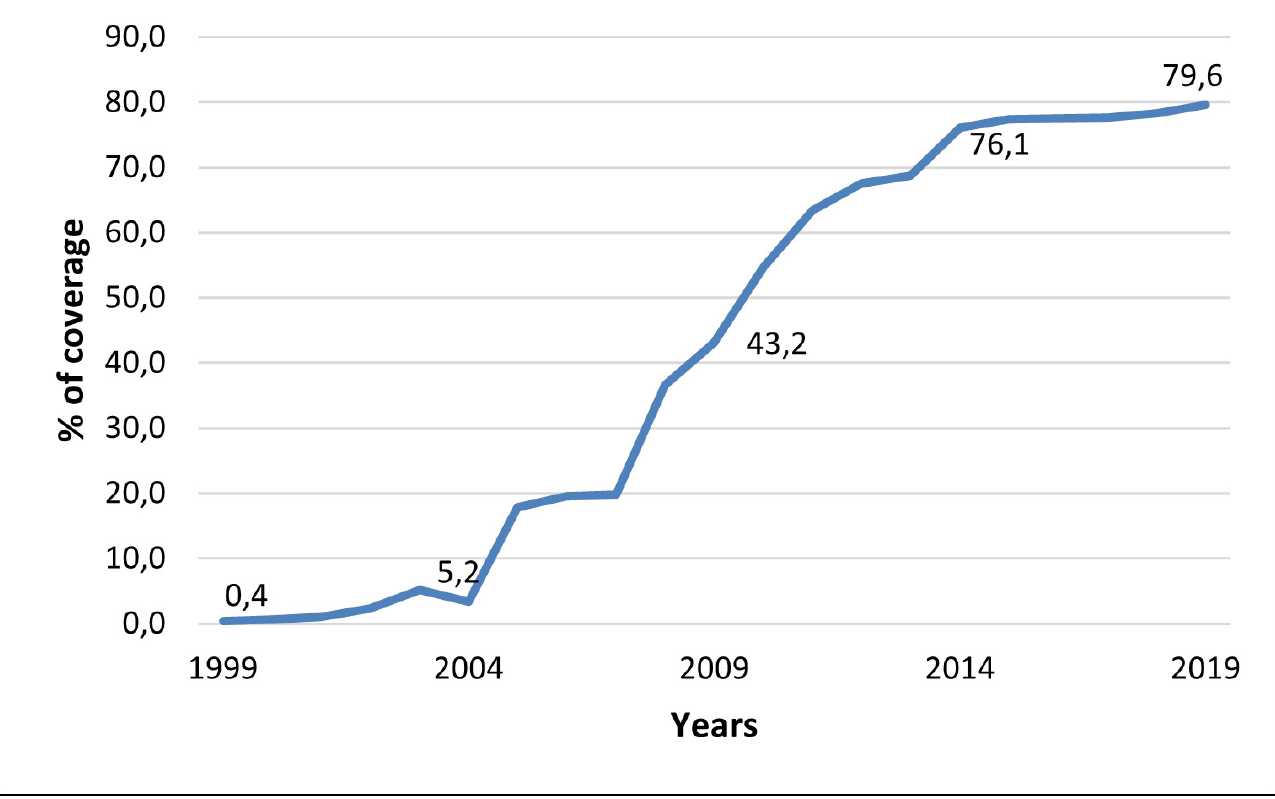
Figure 4. Percentage of coverage, 1999 -